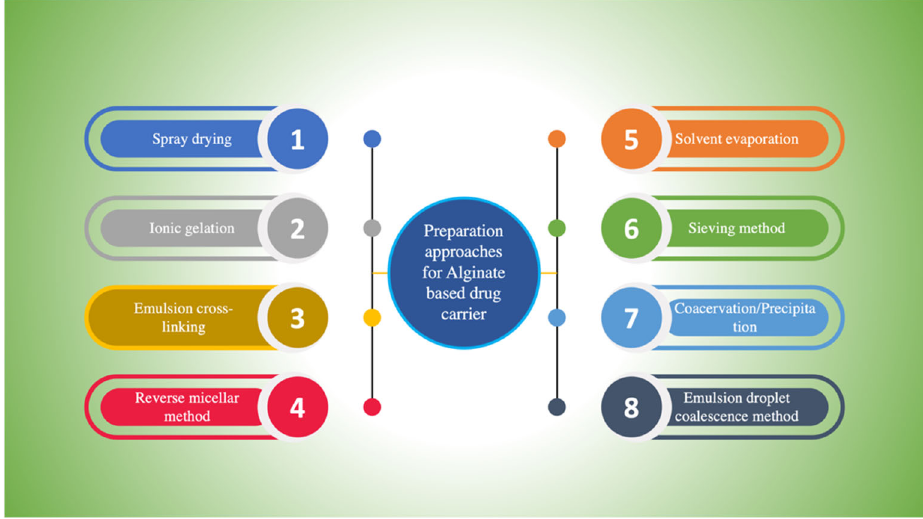
Figure 5. Various approaches for preparing ALG ‐ based particulate carrier matrix.